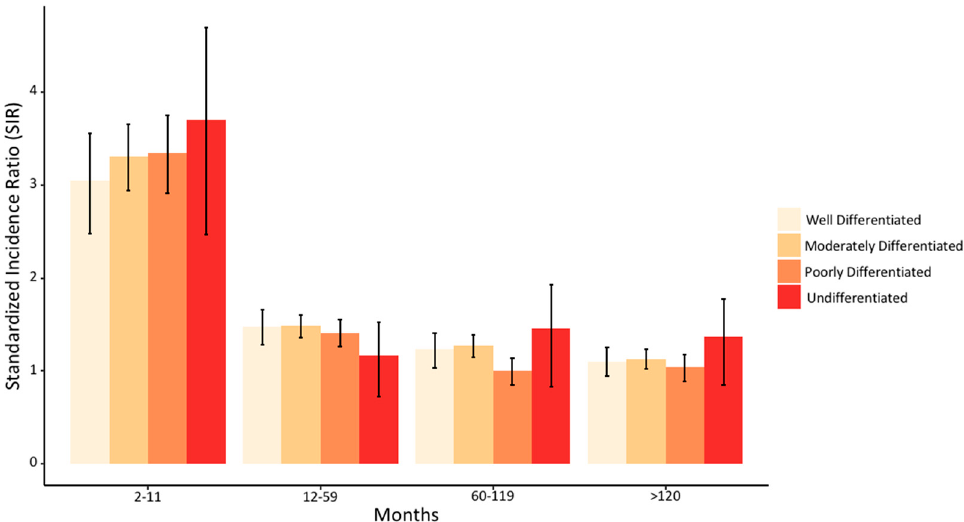
Figure 5. Risk of developing SPTC stratified by tumor differentiation status over time. SIR: stand- ardized incidence ratio (observed/expected).